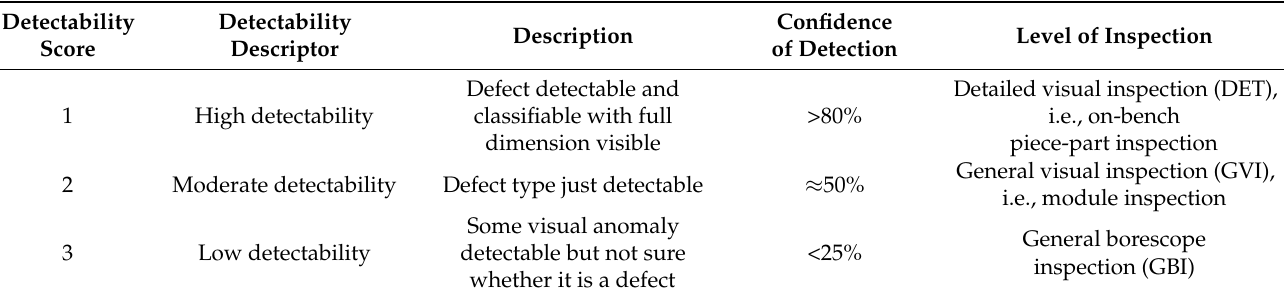
Table 9. Qualitative defect detectability scaling